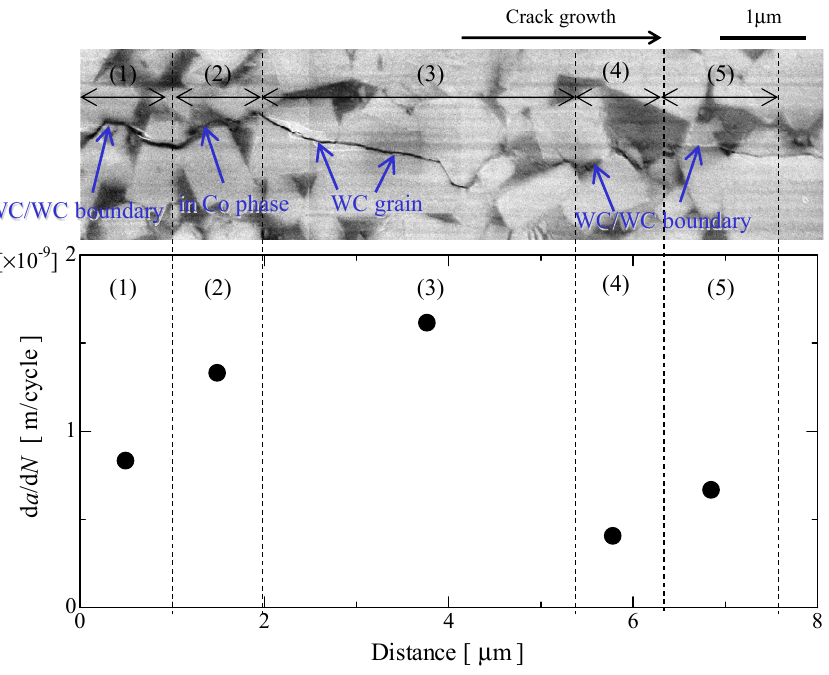
Figure 12. Changes in crack growth rate along the crack path at a constant K max of 7.0 MPam 1/2 .